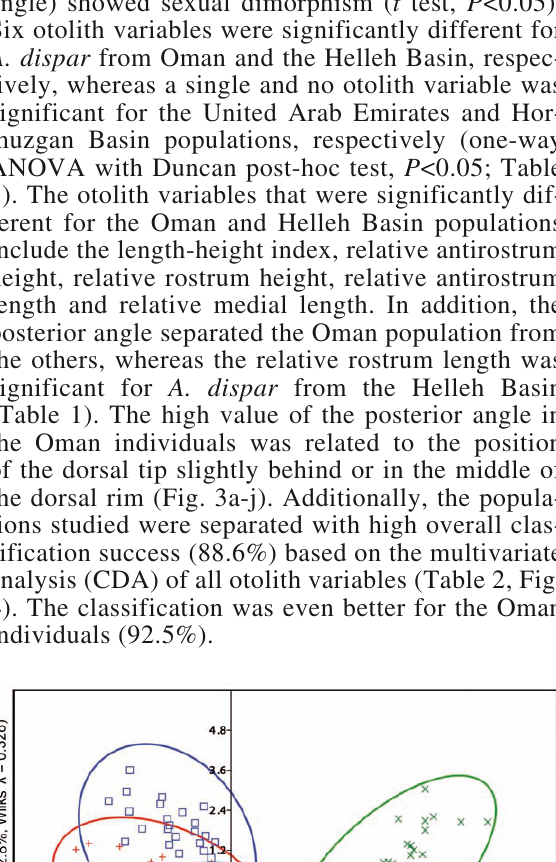
Table 2. – Classification matrix of the CDA (jack-knifed) based on all otolith variables of the studied Aphanius dispar populations.